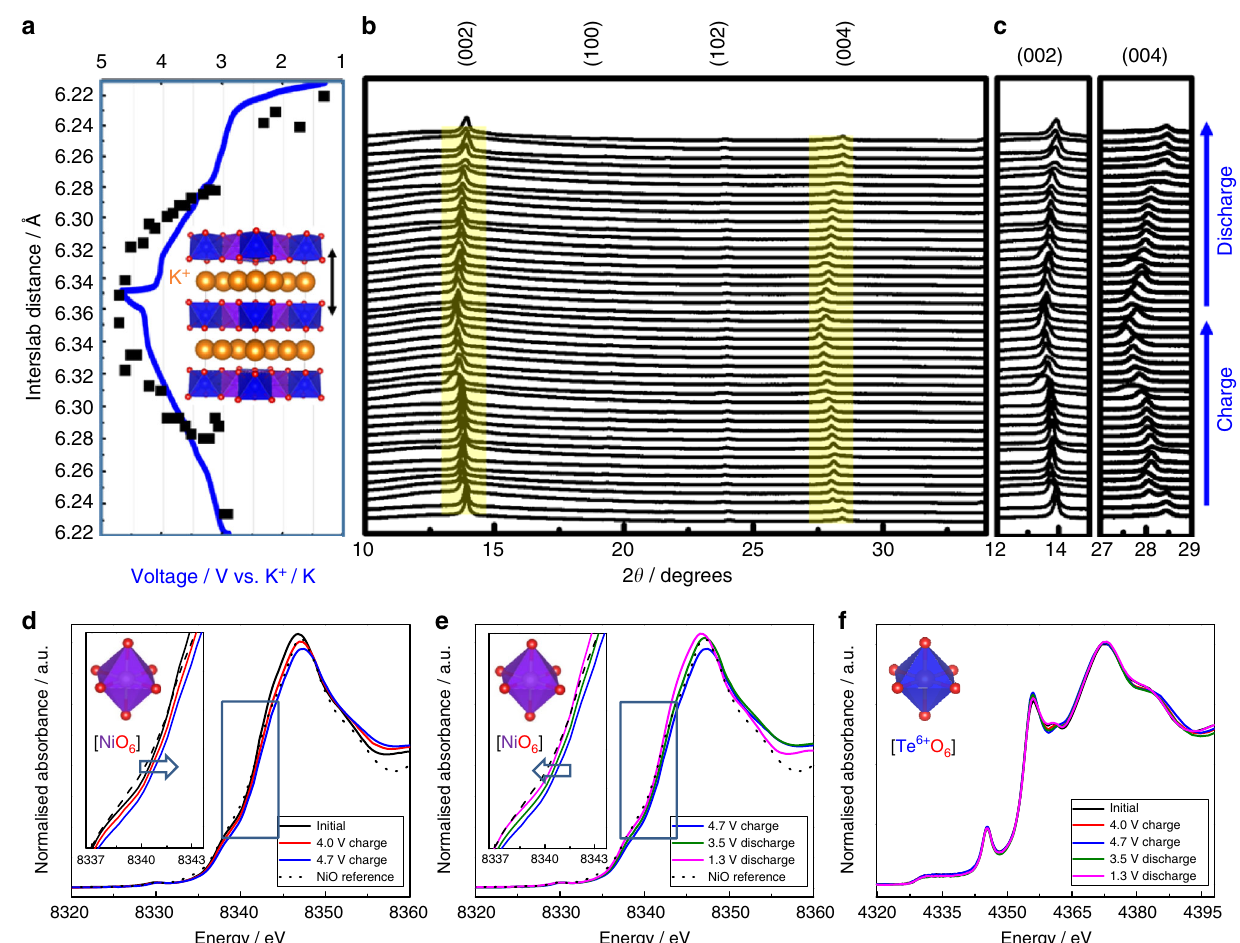
Fig. 4 Crystal and electronic structural changes of P2-type K 2 Ni 2 TeO 6 prototype cathode material during K-ion extraction and insertion. a Interslab distances calculated from ex situ XRD patterns during XRD patterns whilst K 2 Ni 2 TeO 6 is (dis)charged at a current density commensurate to C/20 rate (20 h of (dis)charge). b XRD patterns from 10° to 38° and c enlarged XRD pattern indicating peak shifts of the (00 l ) Bragg diffraction peaks during (dis) charging. d Ni K -edge XANES spectra during charging (K-ion extraction) and e discharging (K-ion insertion). f Te L 3 -edge XAS spectra of K 2 Ni 2 TeO 6 taken at different states of